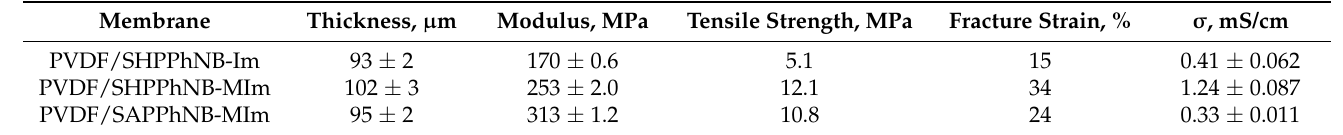
Table 4. Mechanical properties and ionic conductivities of the blend membranes.